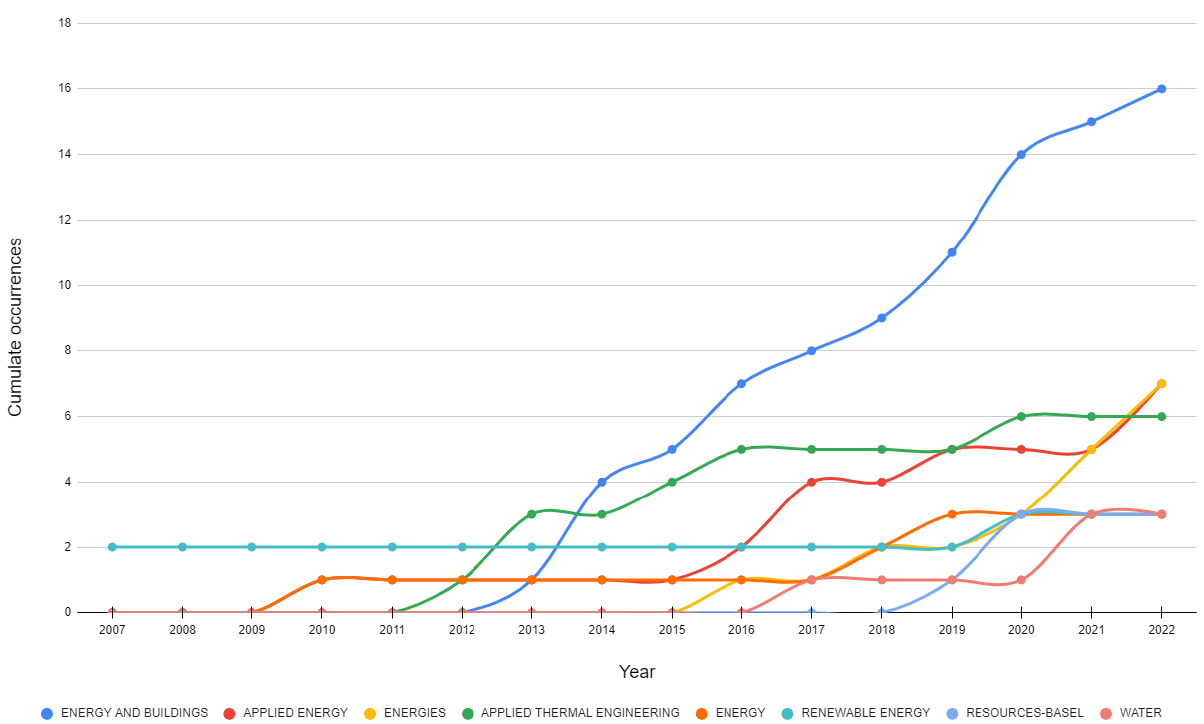
Figure 6. Publications in greywater energy recovery domain in the top eight journals. Table 6. The most productive journals in greywater energy recovery domain.